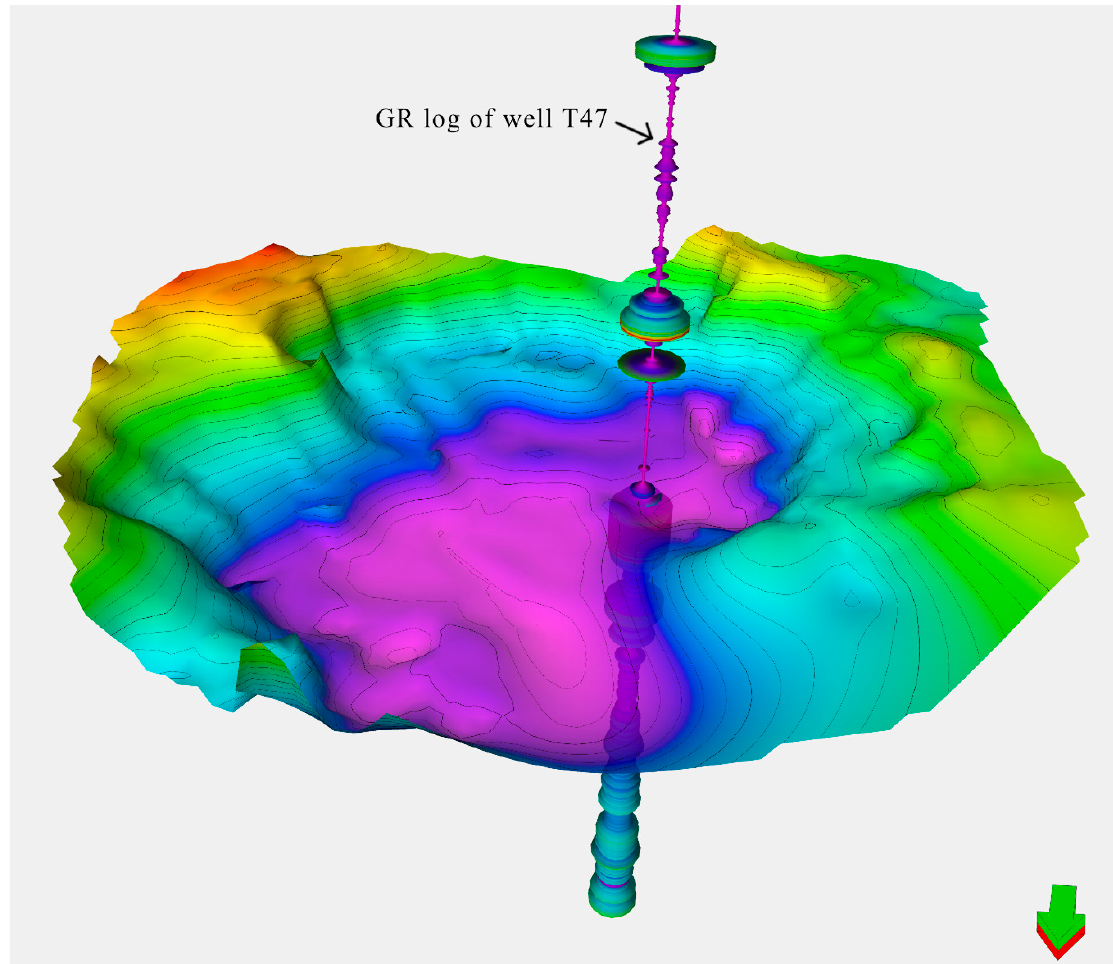
Figure 5. Seismic geo-body of a saucer-shaped sill (“Sill 2” in Figure 3a,b) in three dimensions (3-D) and the location of drilling well T47 which intersected the saucer at depth of 4100–4200 m. The GR log is attached to drilling well T47.